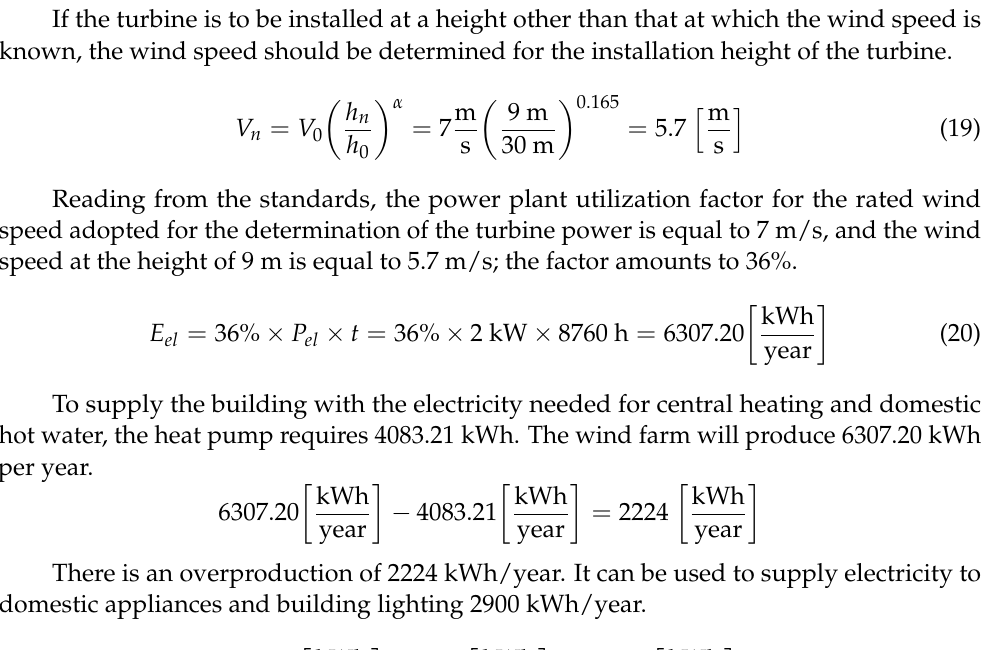
Table 15. Technical parameters of the turbine FLTXNY FH-2000. Technical Parameters of the Wind Turbine Rated power, kW 2 Rated voltage, V 24/48 Take-off wind speed, m/s 2.5 Rated wind speed, m/s Maximum wind speed, m/s Rotor diameter, m 2 Number of rotor blades, pcs. 3 Propeller material